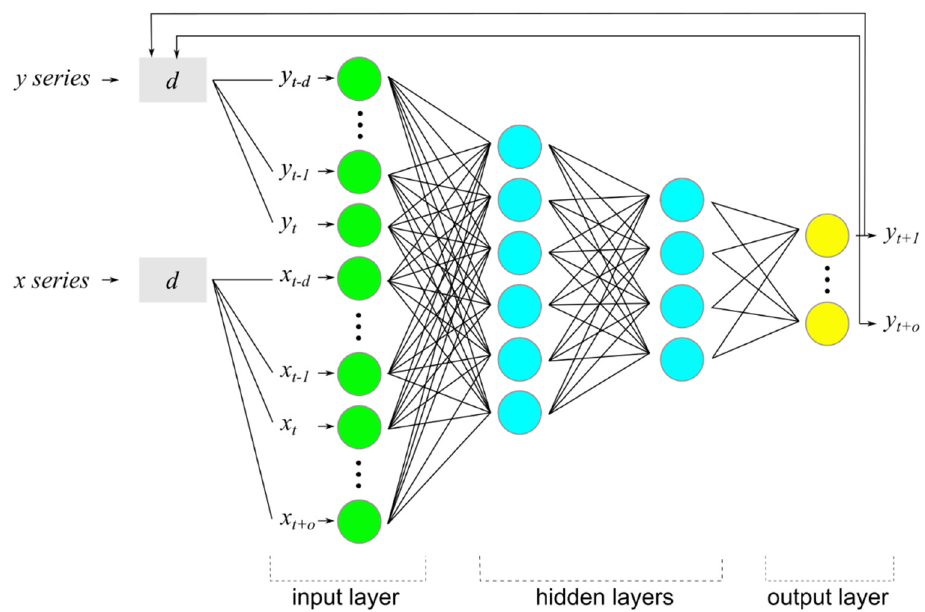
Figure 1. Scheme of the used configuration of the nonlinear autoregressive network with exogenous inputs artificial neural network (NARX ANN).